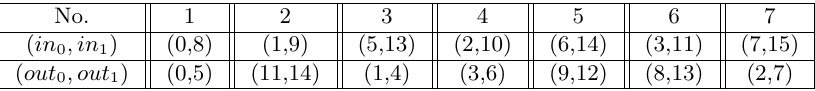
Table 5: Related-Tweak SS Distinguishers for 8-Round QARMA -64